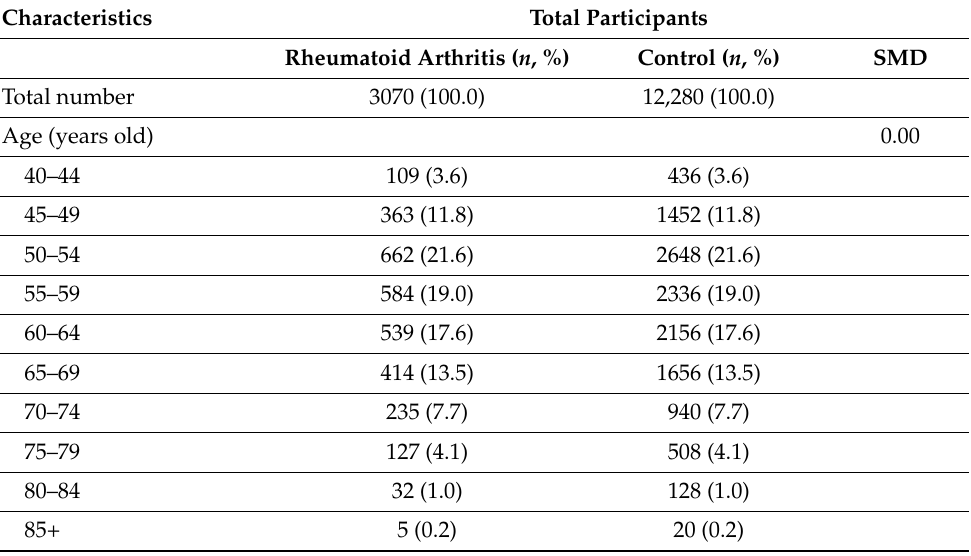
Figure 1. A schematic illustration of the participant selection process in this study. From a total sample of 514,866 patients, 3070 rheumatoid arthritis (RA) participants were matched with 12,280 controls based on age, sex, income, and residential region. Abbreviation: CCI, Charlson comorbidity index. Table 1. General characteristics of